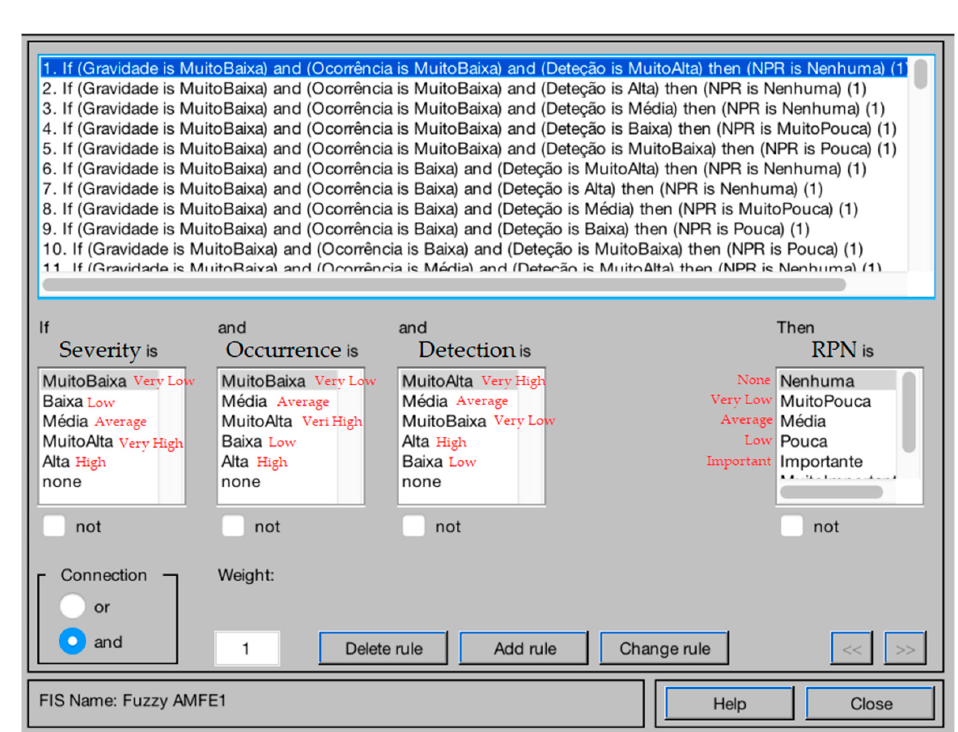
Figure 3. Partial view of the inference rules in MATLAB